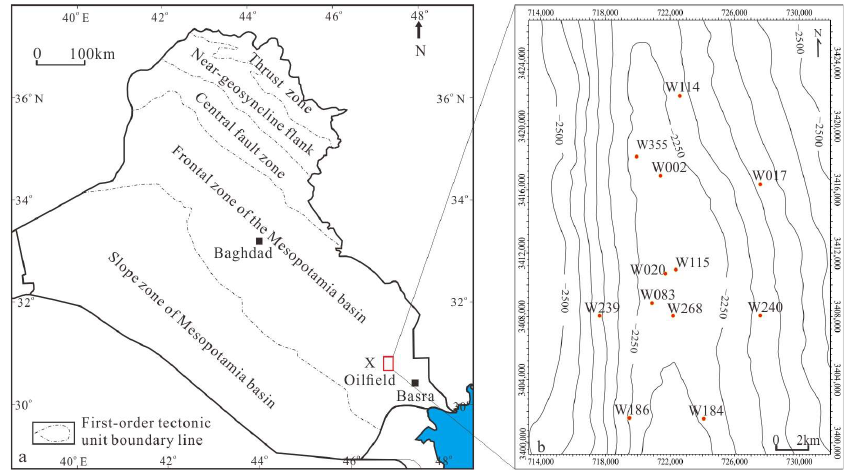
Figure 1. Overview of study area. ( a ) Location of X Oilfield; ( b ) structure of the Mishrif Formation, the red dots represent coring well.